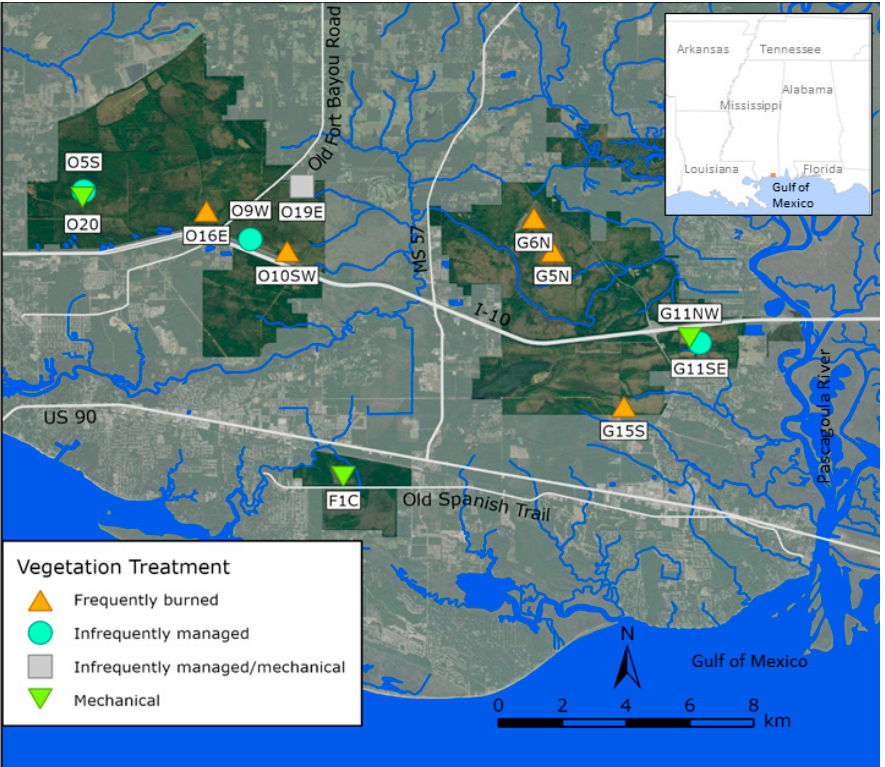
Figure 1. Map of sites sampled on the Mississippi Sandhill Crane National Wildlife Refuge, Jackson County, MS. Labels coincide with site codes in Table 1.